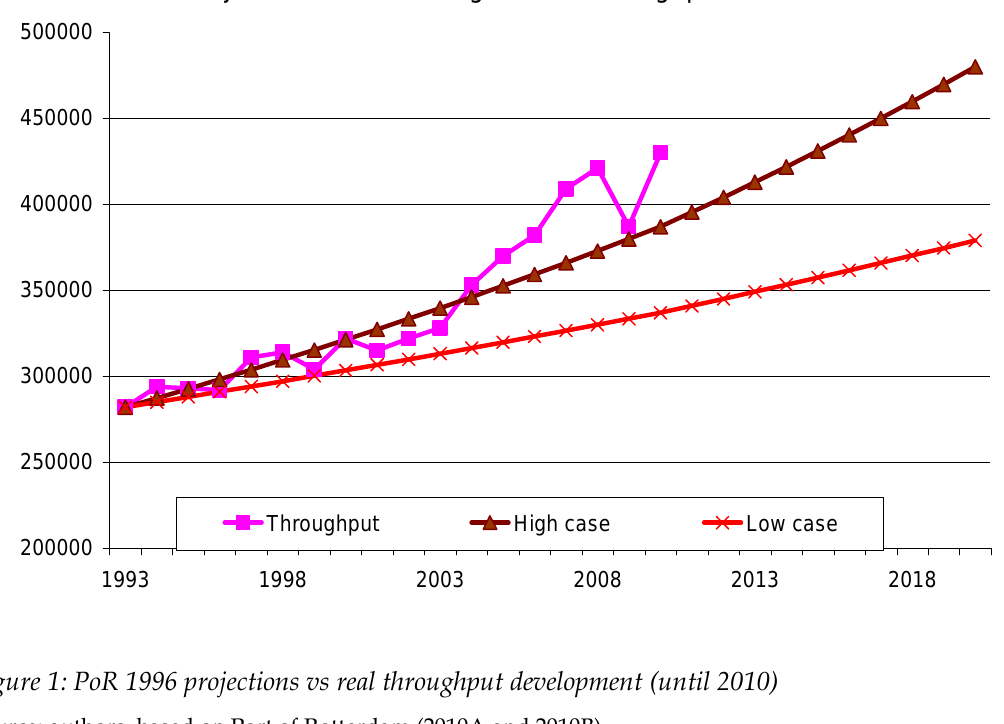
Figure 1: PoR 1996 projections vs real throughput development (until 2010) Source: authors, based on Port of Rotterdam (2010A and